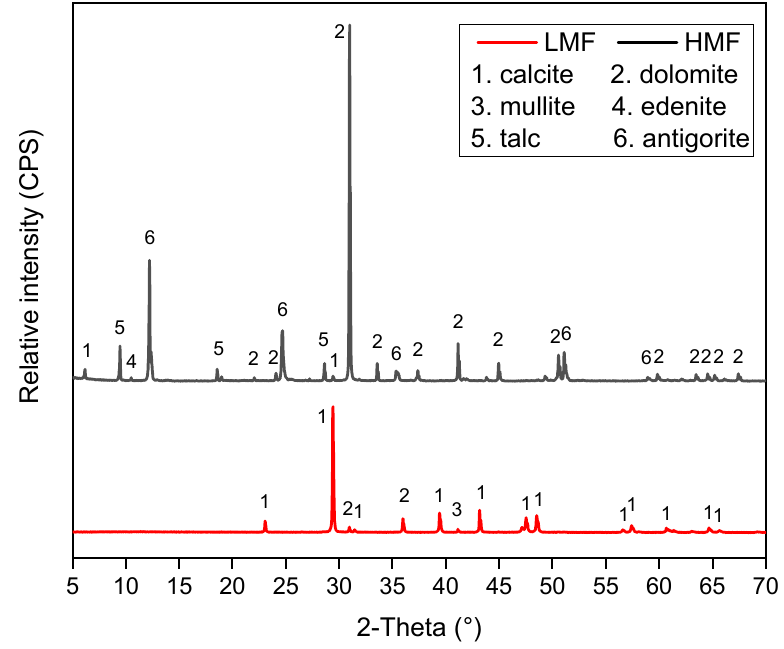
Figure 1. Particle size distributions of LMF and HMF. The Methylene blue test was carried out according to AASHTO T330 and the Methy- lene blue values (MBV) of LMF and HMF were 1.24 mg/g and 1.55 mg/g, respectively. Based on the AASHTO standard, the LMF and HMF with an MBV < 6 mg/g both lay in an excellent range of performance in asphalt mixture. The XRD results in Figure 2 highlight the difference in crystal structures between LMF and HMF.